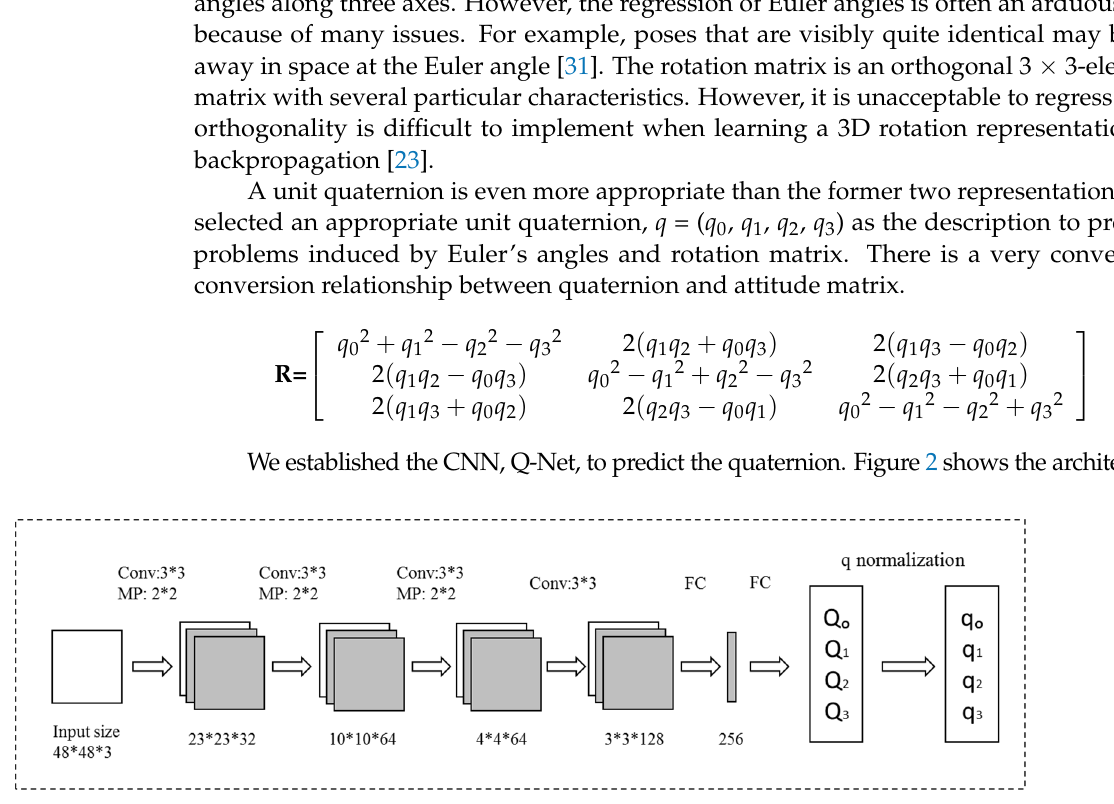
Figure 2. The architecture of Q-Net. “Conv” stands for convolution, “MP” stands for max pooling, and “FC” stands for fully connected. Convolution and max-pooling have step sizes of 1 and 2, respectively.